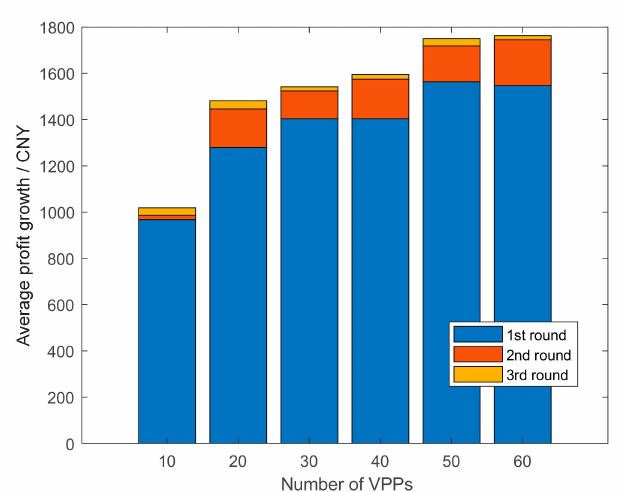
Figure 13. Average profit growth with di ff erent numbers of